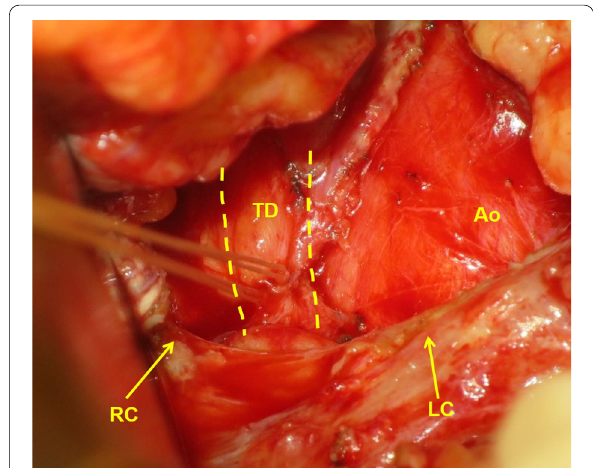
Fig. 1 Ligation of a right-sided thoracic duct. Mass ligation of the fat tissue surrounded by the right wall of the aorta, the azygos vein, and the vertebral body, which contains the right-sided thoracic duct. TD thoracic duct, RC right crus of the diaphragm, LC left crus of the diaphragm, Ao aorta